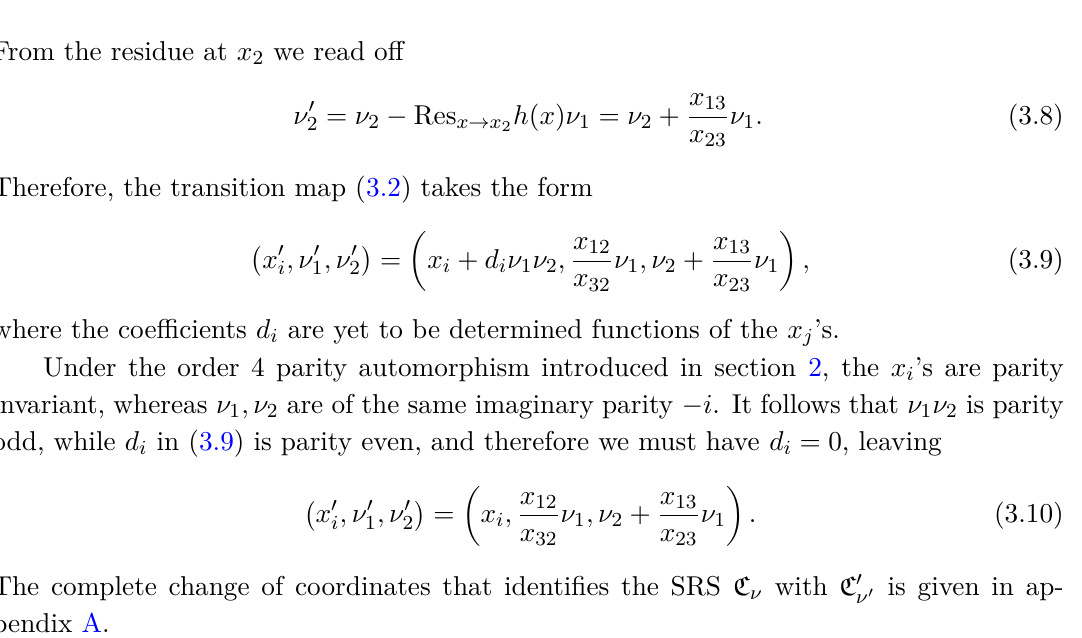
Figure 2 . The top and bottom diagrams illustrate two different sets of coordinates charts on the SRS C ν in the odd spin structure case. The six branch points of the underlying hyperelliptic curve are marked with crosses, with the five q ( x ) = 0 branch points grouped together on the left, and the remaining p ( x ) = 0 branch point on the right. Top: the unprimed coordinate system becomes singular near the branch points x 1 , x 2 , whose neighborhoods are coordinatized by ( w 1 , η 1 ) and ( w 2 , η 2 ) respectively. Bottom: the primed coordinate system becomes singular near the branch points x 2 and x 3 , whose neighborhoods are parameterized by ( w 2 , η 2 ) and unprimed coordinates ( y, η )